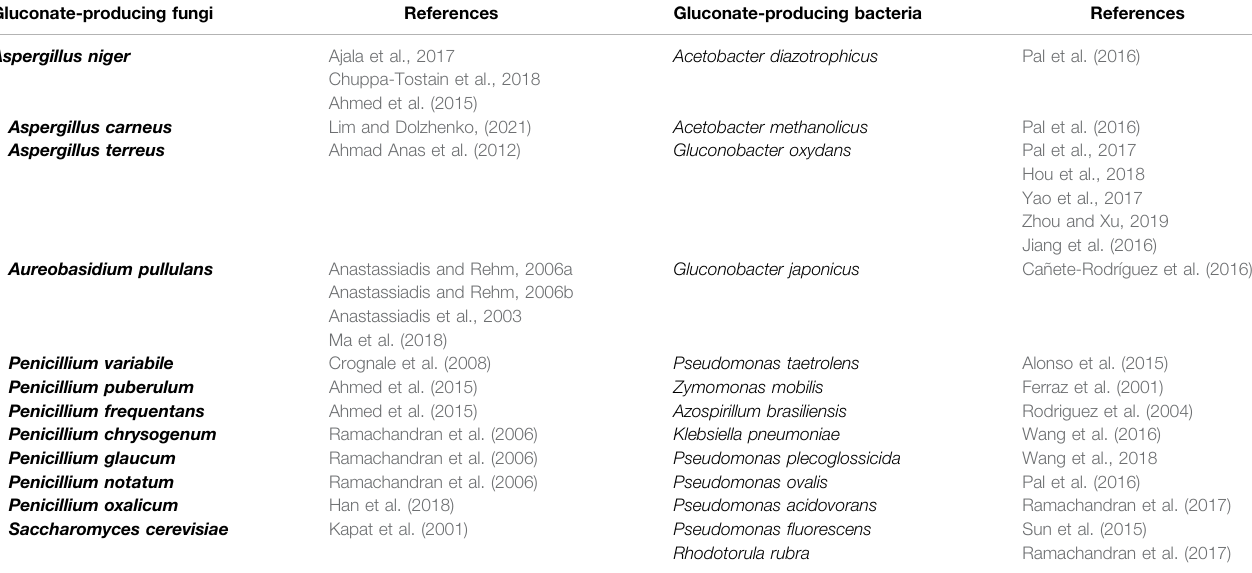
TABLE 1 | Gluconate-producing fungi and bacteria with application value in the last